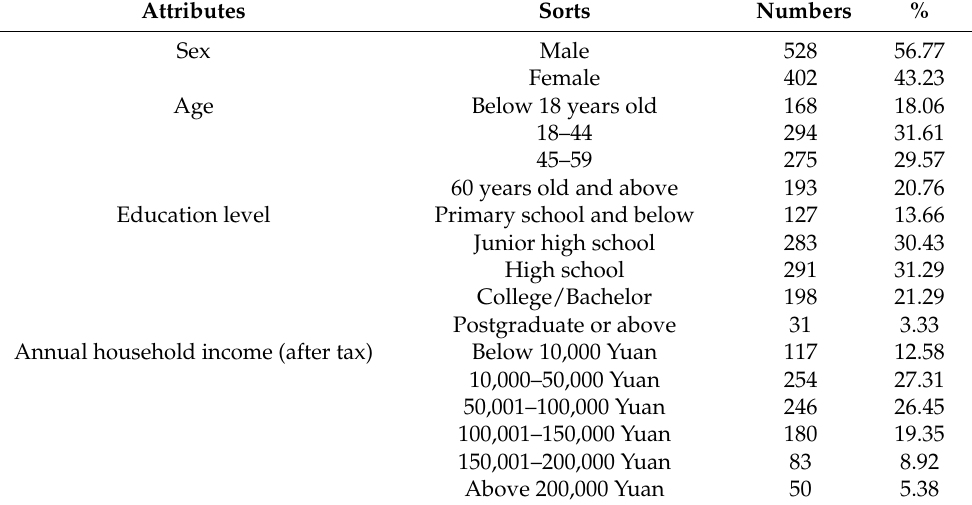
Table 2. Samples’ sociodemographic